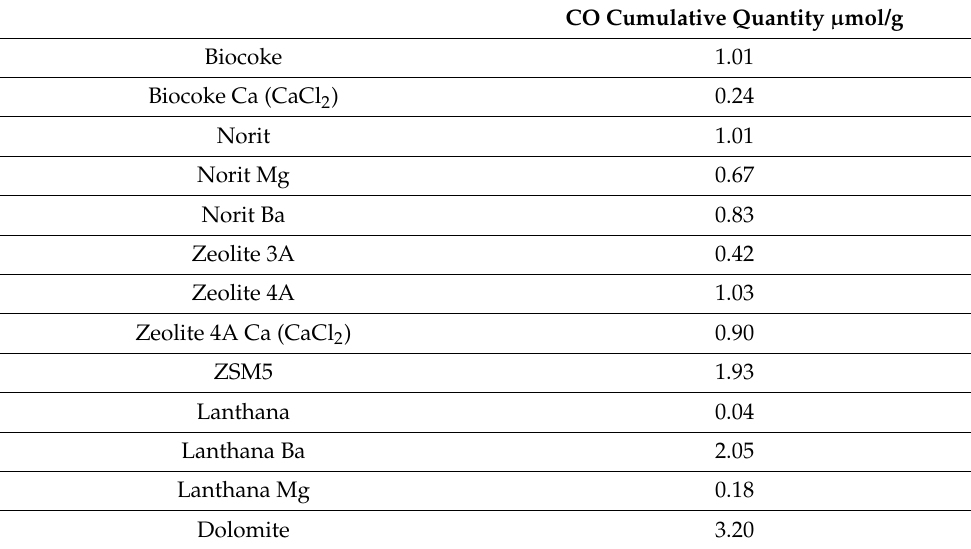
Table 4. CO cumulative quantity per gram of calcined sorbents, measured by CO